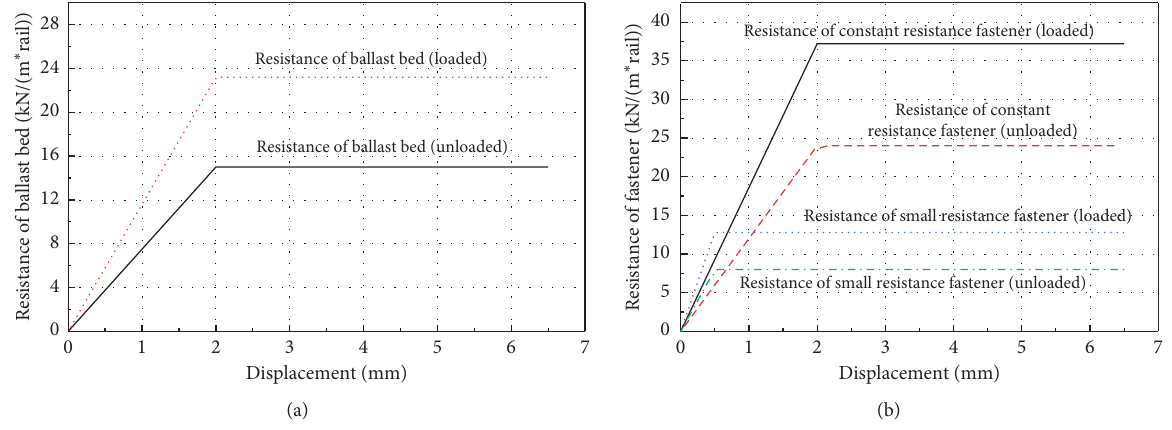
Figure 3: Longitudinal resistance-displacement diagram. (a) Ballast bed. (b) Fastener. Table 1: Main parameters.